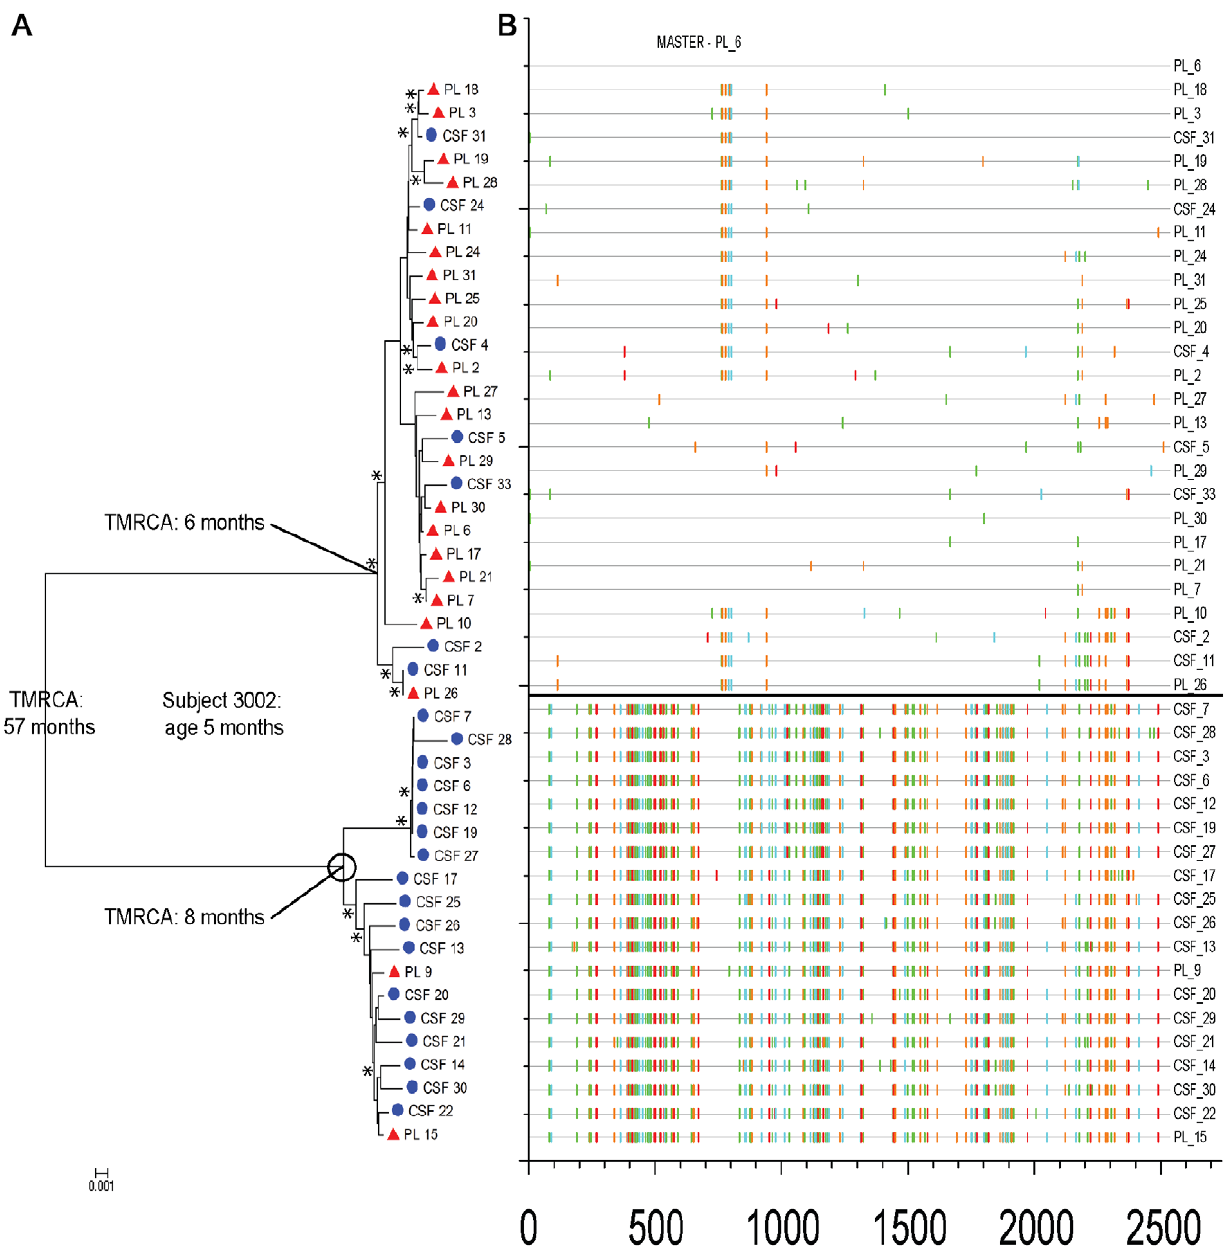
Figure 4. Evidence of multiple transmission events during pediatric HIV-1 subtype C infection. Phylogenetic and sequence analysis of plasma and CSF HIV-1 populations for subject 3002. (a) Neighbor-joining tree. Sequences from the CSF are labeled with solid blue circles, and plasma sequences (PL) are labeled with solid red triangles. Bootstrap values $ 40 are indicated ( * ) at the appropriate nodes. Genetic distance is scaled at the bottom of the figure (0.001) and indicates the number of nucleotide substitutions per site between env sequences. The subject’s age is noted, as well as the overall TMRCA and the TMRCA of the two transmitted viruses. The CNS sequestered population is represented by an open black circle. (b) Highlighter plot of aligned env plasma and CSF sequences, generated at www.hiv.lanl.gov. The HXB2 nucleotide position number is indicated on the x axis, and the sequence identifier is indicated on the y axis. Nucleotide changes are indicated by the following ticks on the highlighter plot: A, green; T, red; G, orange; and C, blue. The two transmitted populations are separated by a heavy black line.